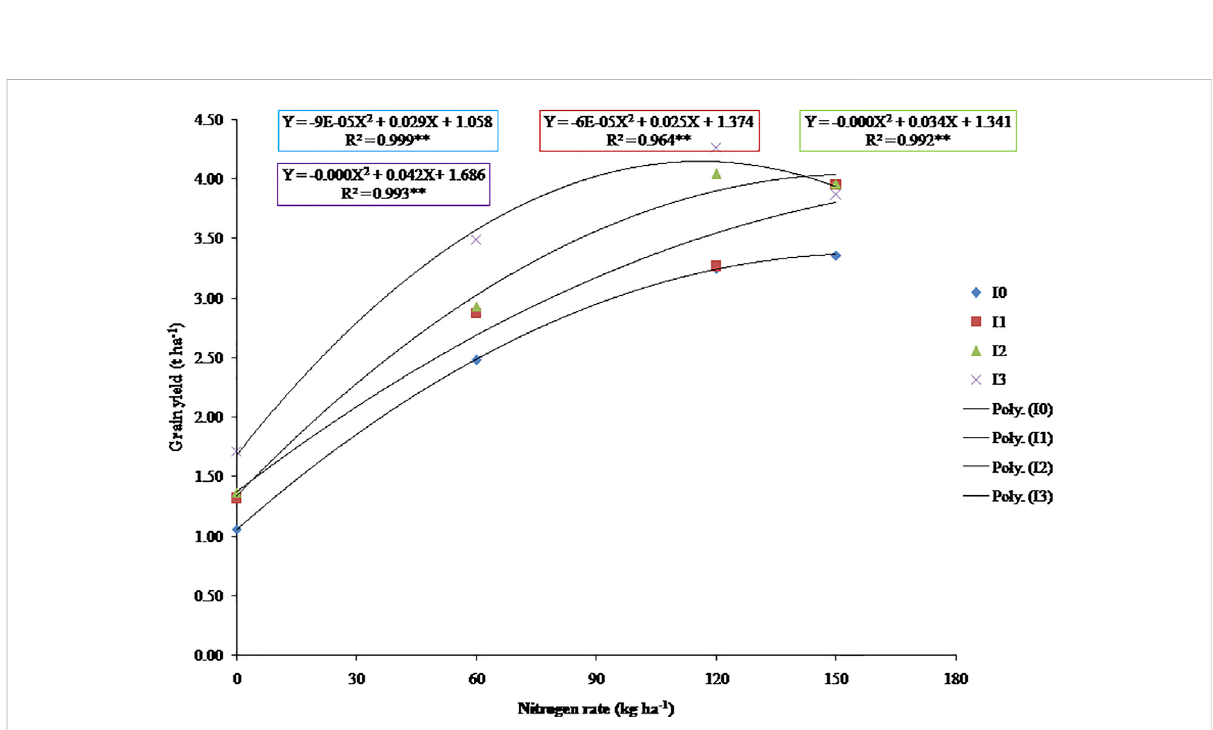
FIGURE 6 Grain yield as affected by nitrogen rates under four irrigation regimes after 2 years of pooled